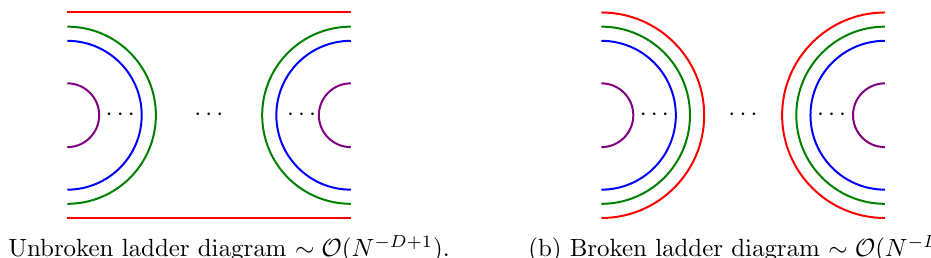
Figure 24. Unbroken and broken ladder diagrams (without the contraction of gauge indices) in rank- D tensor